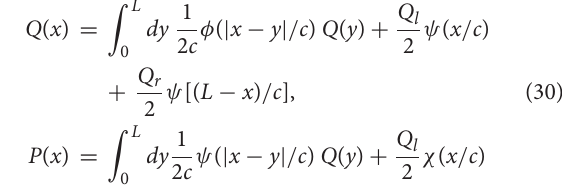
ν . Note that the usual Lévy 3 = −